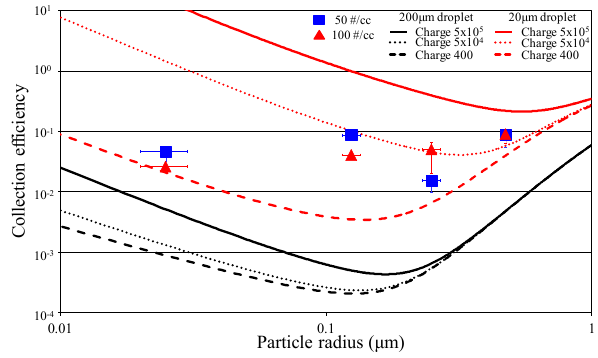
Figure 11. CE as a function of particle radius under high-RH con- ditions. CE experimentally determined in this study (points) with theoretical calculations (lines), where the charge number is in ele- mentary charge units per droplet. Black lines are for CE of 200µm droplet size and red for 20µm droplet